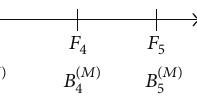
Figure 1: Set of clock frequencies implemented by the router, and relative maximum supported